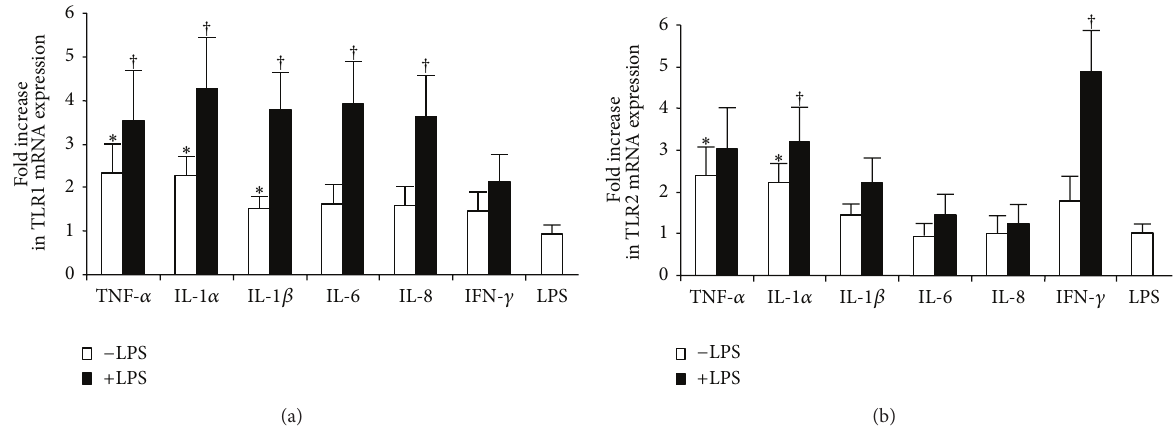
Figure 5: TNF- 𝛼 (10ng/mL), IL-1 𝛼 (10ng/mL), IL-1 𝛽 (10ng/mL), IL-6 (10ng/mL), IL-8 (10ng/mL), and IFN- 𝛾 (40 ng/mL) stimulated TLR1 and TLR2 mRNA expression in submerged primary conjunctival epithelial cells with and without 50 ng/mL LPS. TLR expression in cells cultured in normal medium was used as reference for the calculation of fold increase. Open bars represent the averaged increase when cells were stimulated with cytokine alone. Solid black bars represent the averaged increase when cells were costimulated with indicated cytokines and LPS. The experiments were repeated in three different batches of cells, and the averaged results were presented. 𝑌 error bars represent the standard deviation of the averaged results. Asterisks ( ∗ ) denote significant difference when cytokine alone was compared to that without stimulation, and ( † ) denotes significant difference when cytokine alone was compared to that with LPS.